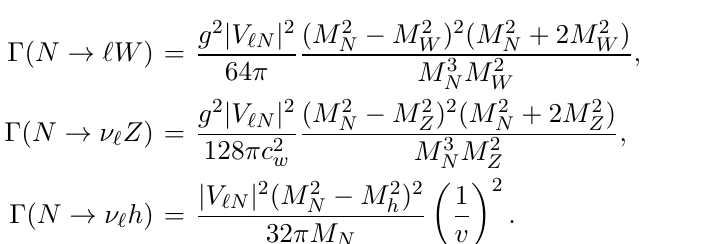
2 . (Right) Heavy neutrino V (cid:22)N j j